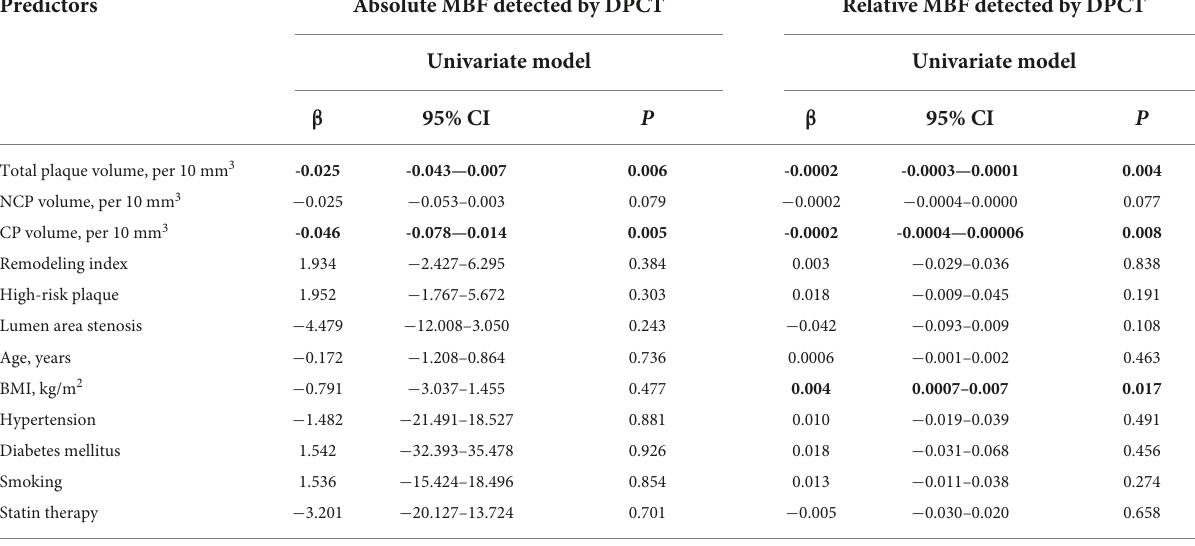
TABLE 3 Univariate analysis of the predictors of absolute and relative myocardial blood flow (MBFi) detected by DPCT using linear mixed models. Predictors